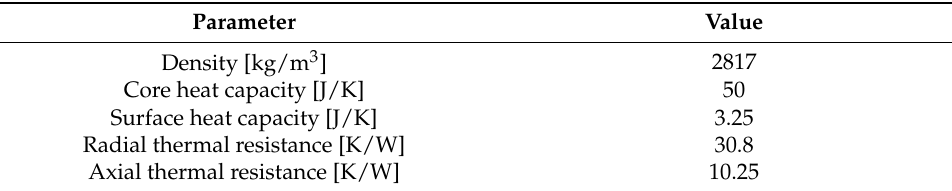
Table 1. Battery cell